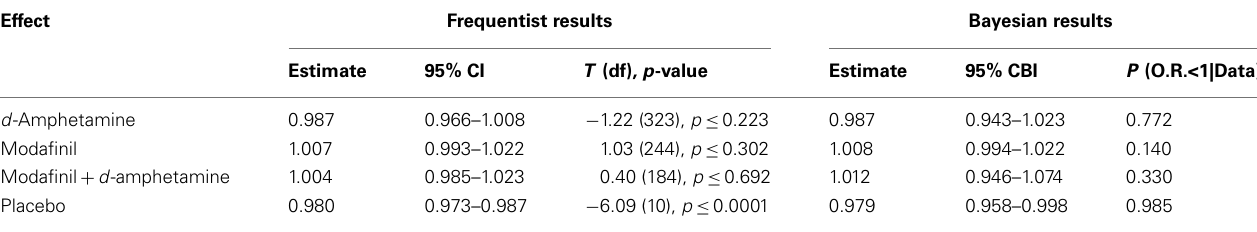
Table 2 | Frequentist and Bayesian results for the simple effects of time within each treatment condition on cocaine-positive